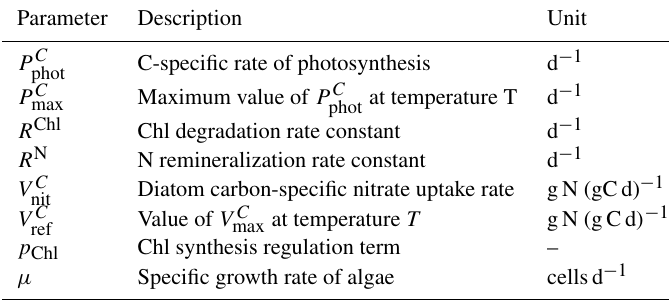
Table A5. Other parameters calculated and used in the model